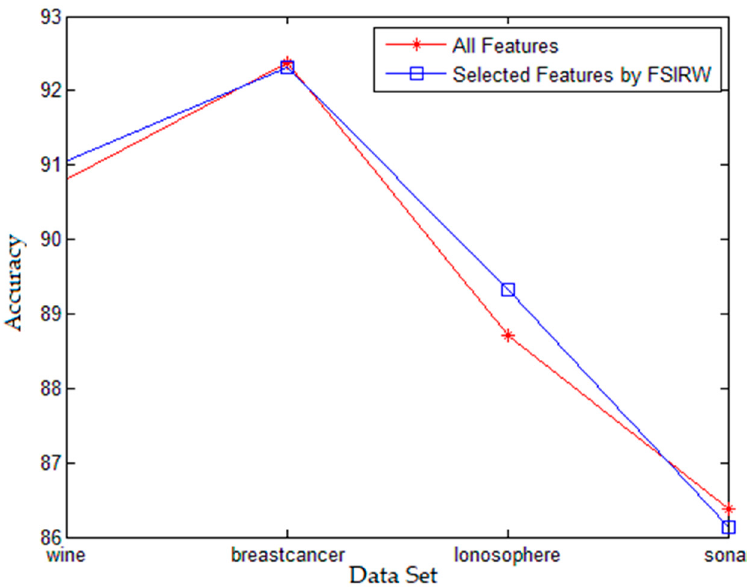
Figure 2. Accuracy Rate of FSIRW Algorithm